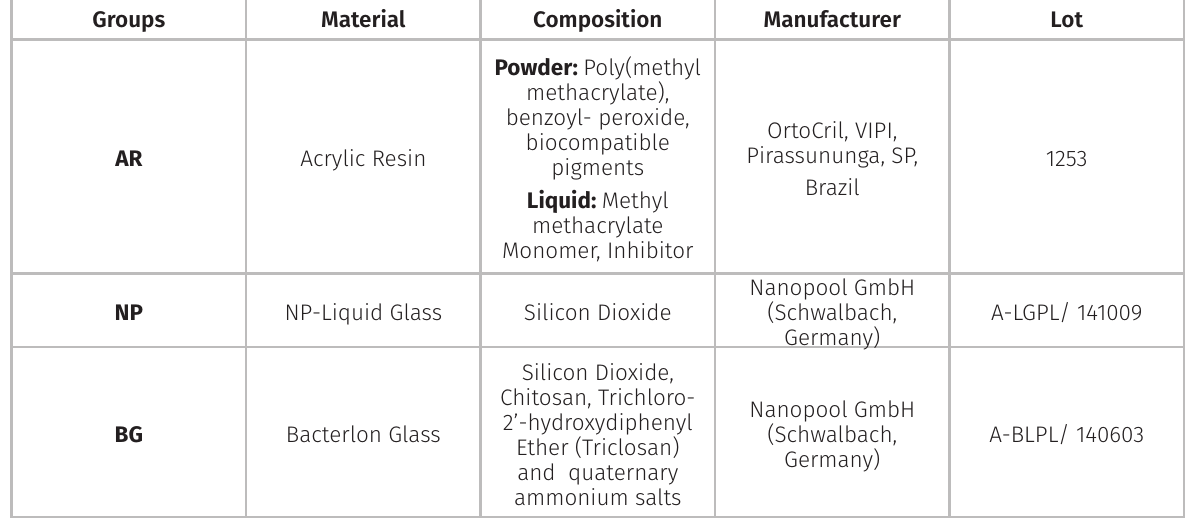
Table I. Silicon dioxide nanofilms tested in this study.